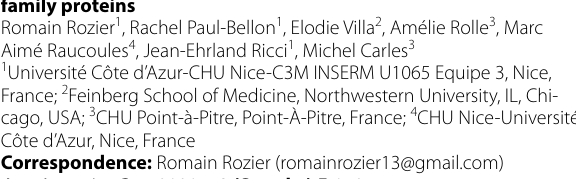
5 and 5 mmHg. AU, − +